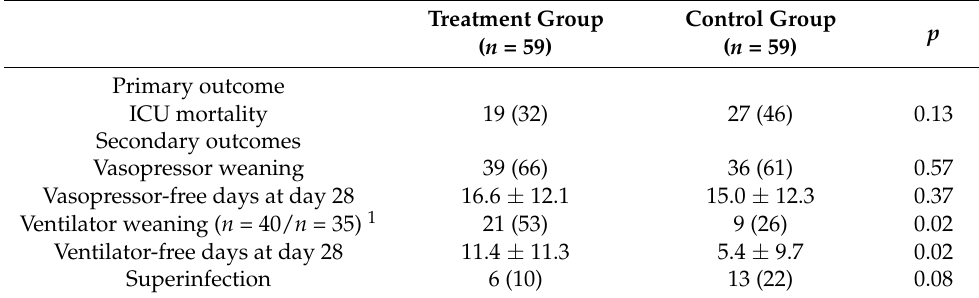
Table 3. Primary and secondary outcomes in the matched cohort.